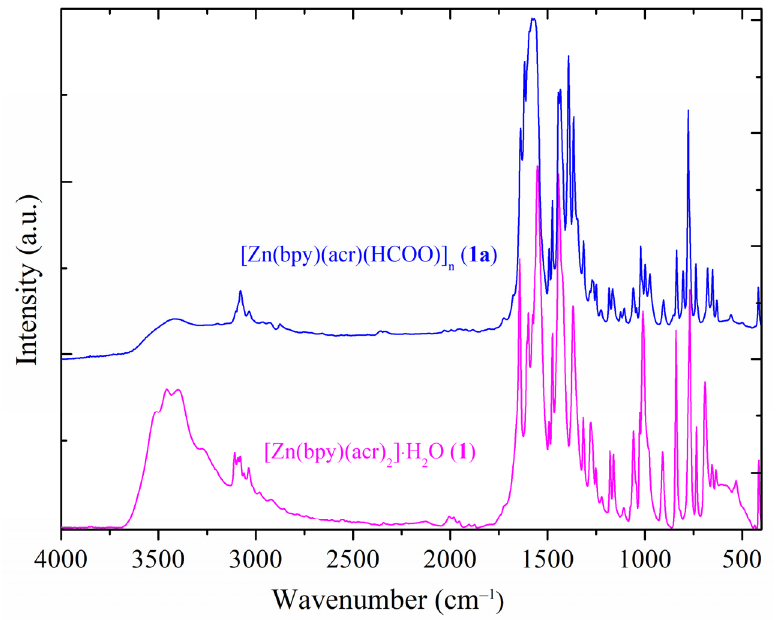
Figure 3. IR spectra of complexes [Zn(bpy)(acr)(HCOO)] n ( 1a) (blue) and its